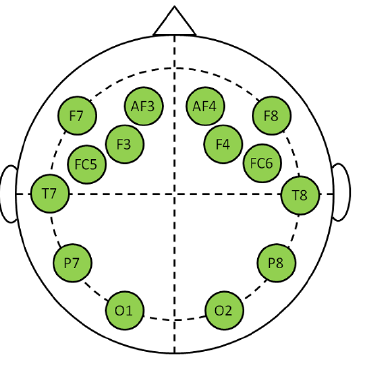
Figure 6. EEG sensors placed over cortex